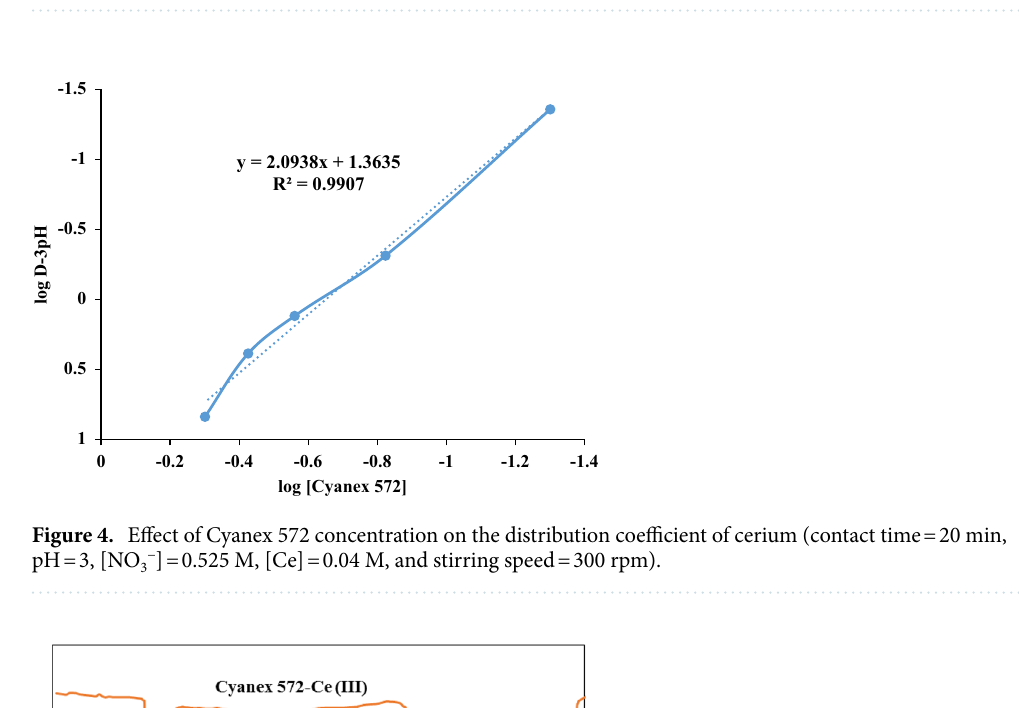
Figure 3. Influence of equilibrium pH on the distribution coefficient of cerium (contact time = 20 min, [Ce] = 0.04 M, [Cyanex 572] = 0.5 M, and stirring speed = 300 rpm).